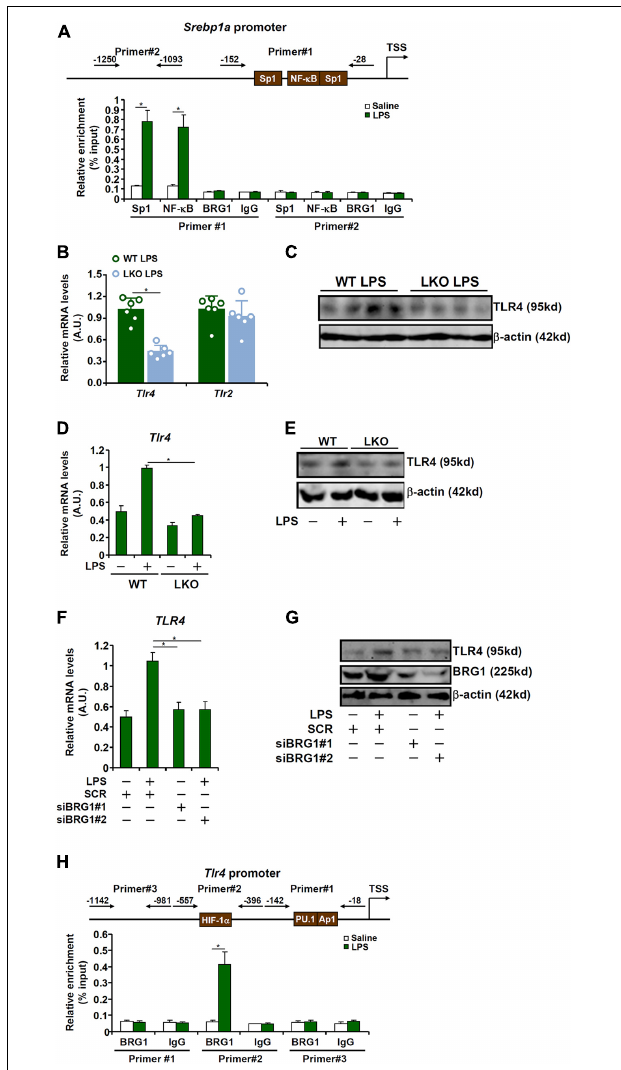
FIGURE 3 | BRG1 contributes to SREBP1a induction by LPS via TLR4. (A) Primary murine hepatocytes were treated with or without LPS (1 µ g/ml) for 12 h. ChIP assays were performed with anti-Sp1, anti-NF- κ B, anti-BRG1, or IgG. (B,C) WT and BRG1 LKO mice were injected peritoneally with LPS (15 mg/kg) and sacrificed 24 h after the injection. TLR expression level was examined by qPCR and Western. (D,E) Primary hepatocytes isolated from WT and BRG1 LKO mice were exposed to LPS (1 µ g/ml) for 12 h and TLR4 expression was examined by qPCR and Western. (F,G) HepG2 cells were transfected with siRNA targeting BRG1 or scrambled siRNA (SCR) followed by treatment with LPS (1 µ g/ml) for 12 h and TLR4 expression was examined by qPCR and Western. (H) Primary murine hepatocytes were treated with or without LPS (1 µ g/ml) for 12 h. ChIP assays were performed with anti-BRG1 or